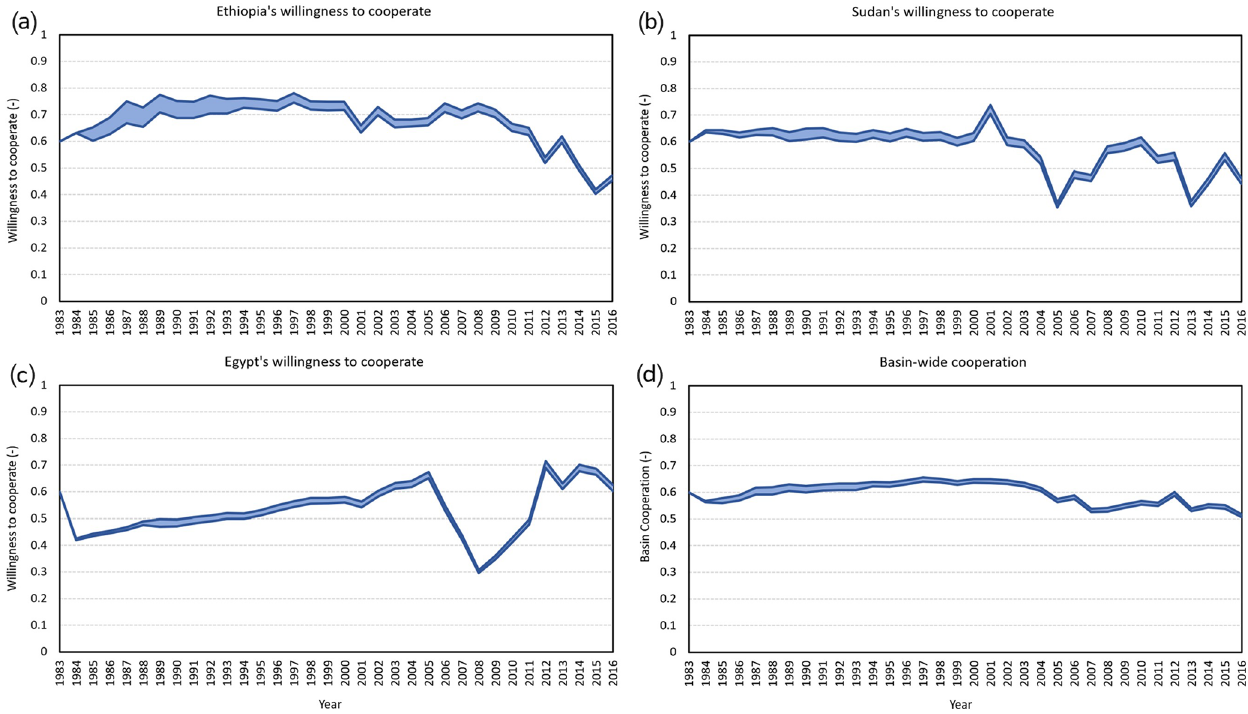
Figure 8. (a–c) Ethiopia’s, Sudan’s, and Egypt’s willingness to cooperate, respectively, and (d) basin-wide cooperation in the ENB, with the uncertainty of the stochastic decision-making (Eq. 7) of the Eastern Nile Basin Socio-hydrological model indicated. The envelope shows 1000 possible trajectories regarding the stochasticity in a country’s